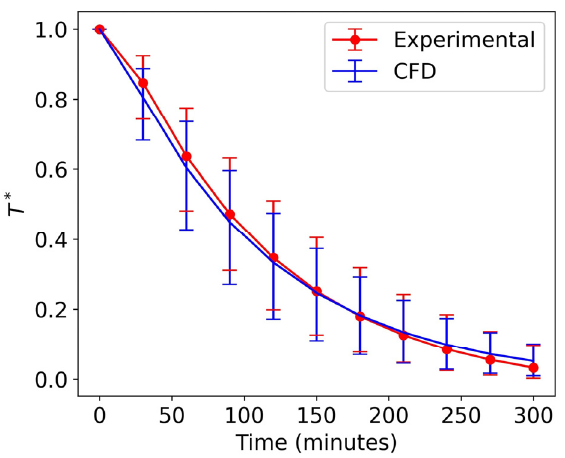
Figure 6. Comparison between the average experimental temperature measurements with respect to time and the average corresponding temperatures obtained numerically for all of the cooled products (crate B).